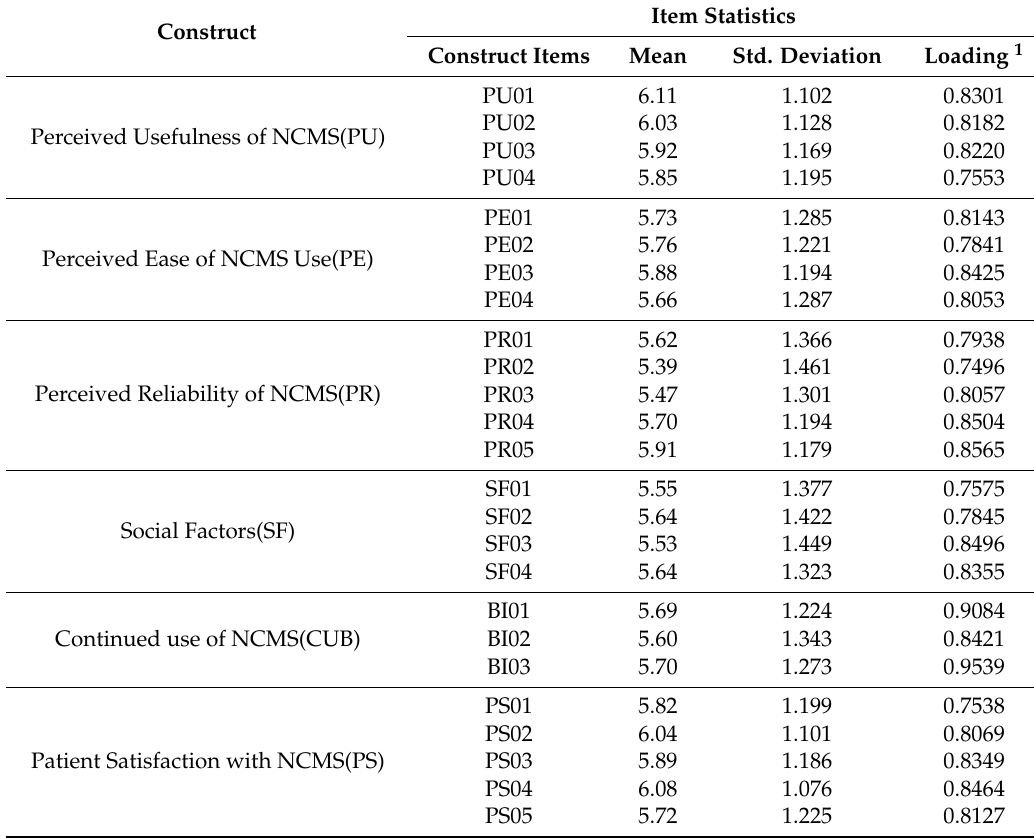
Table A1. Descriptive Statistics of the